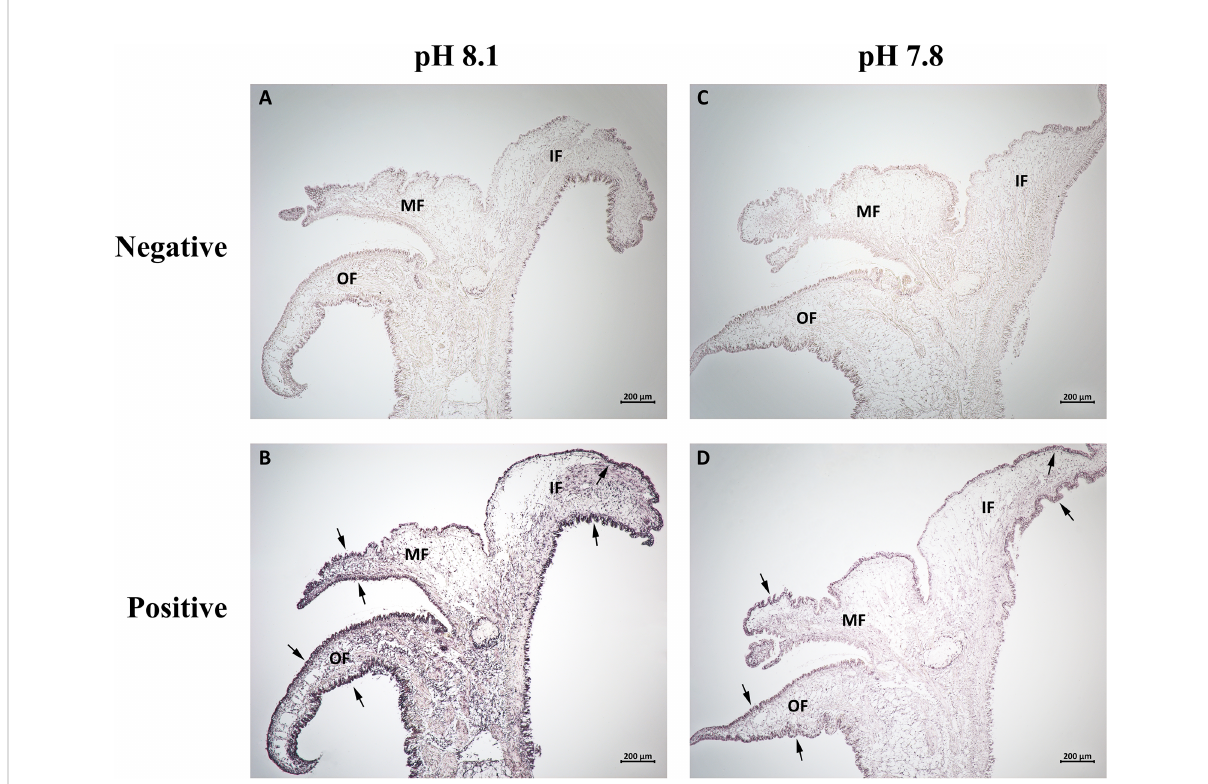
FIGURE 4 In situ hybridization analysis of Cg CaM mRNA in the mantle of oyster C. gigas under acidi fi cation treatment. The sections of the oyster mantle were (A, C) hybridized with the sense RNA probes as negative control, while (B, D) hybridized with the anti-sense RNA probes were the positive group. The hybridization positive signals were labeled with arrows. OF, outer fold; MF, middle fold; IF, inner